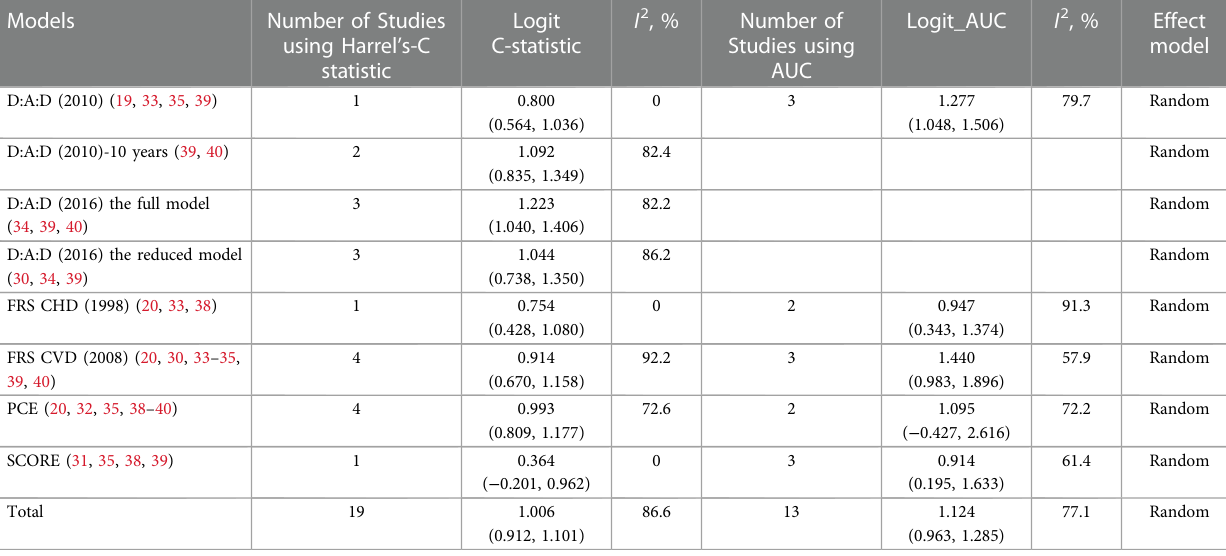
TABLE 3 Meta-analysis of the Harrel ’ s C-statistic and AUC respectively of the CVD models for PLWH.